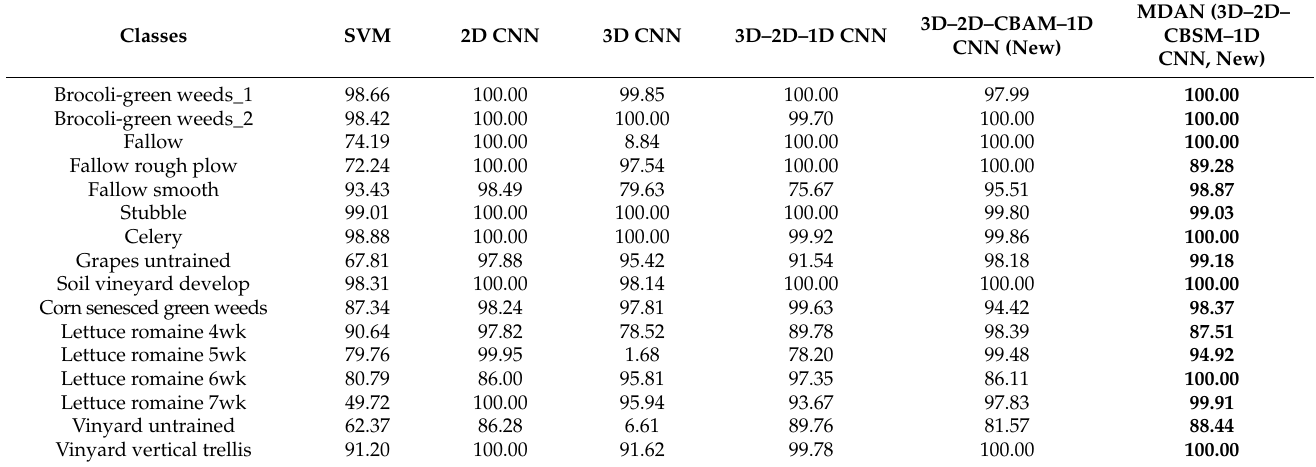
Table 6. Classification accuracies of the SA dataset. This table shows the best performances in bold.